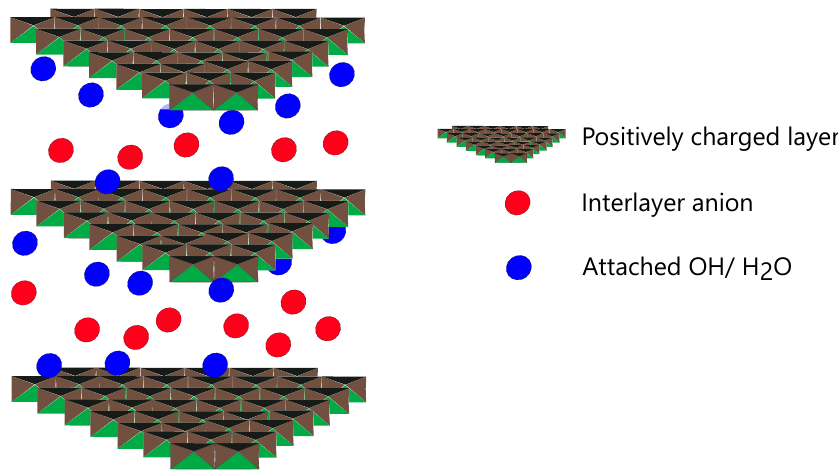
Figure 2. Schematic representation of Layered Double Hydroxide (LDH)